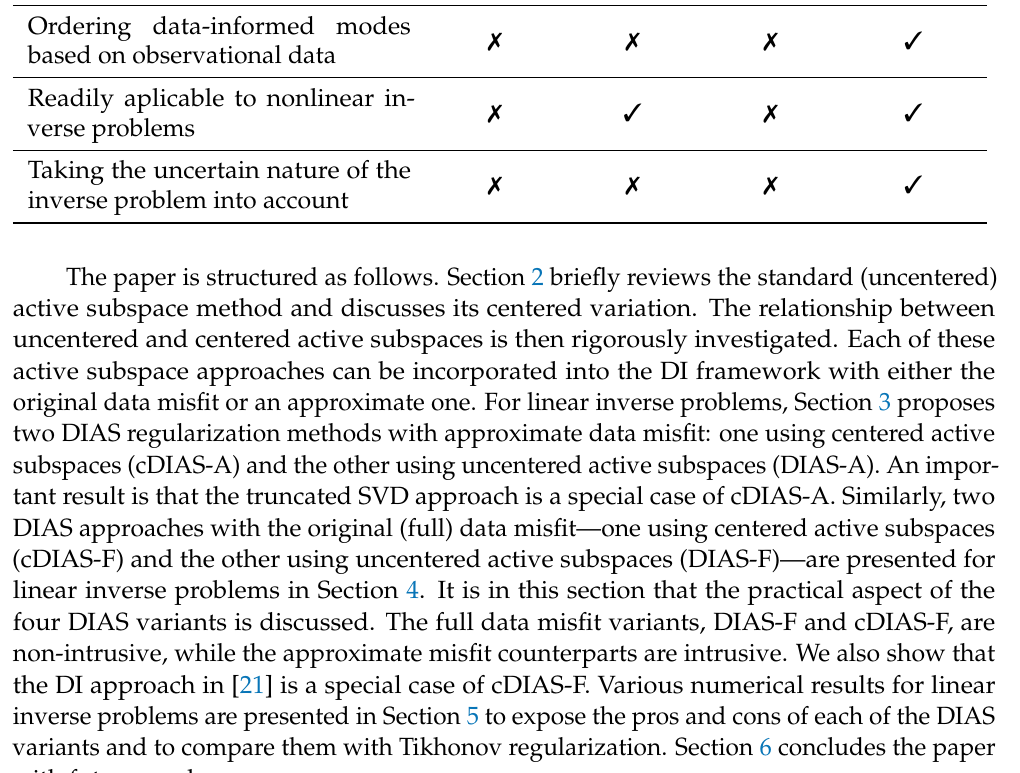
Table 1. Comparison of features between different approaches ( (cid:51) = possess, (cid:55) = not possess). TSVD Tikhonov DI [21] DIAS Solving ill-posed inverse